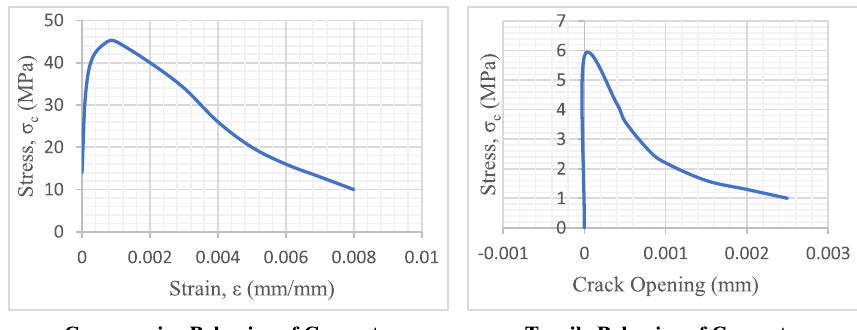
Fig. 4 Stress-strain curve for compressive and tensile behavior of concrete